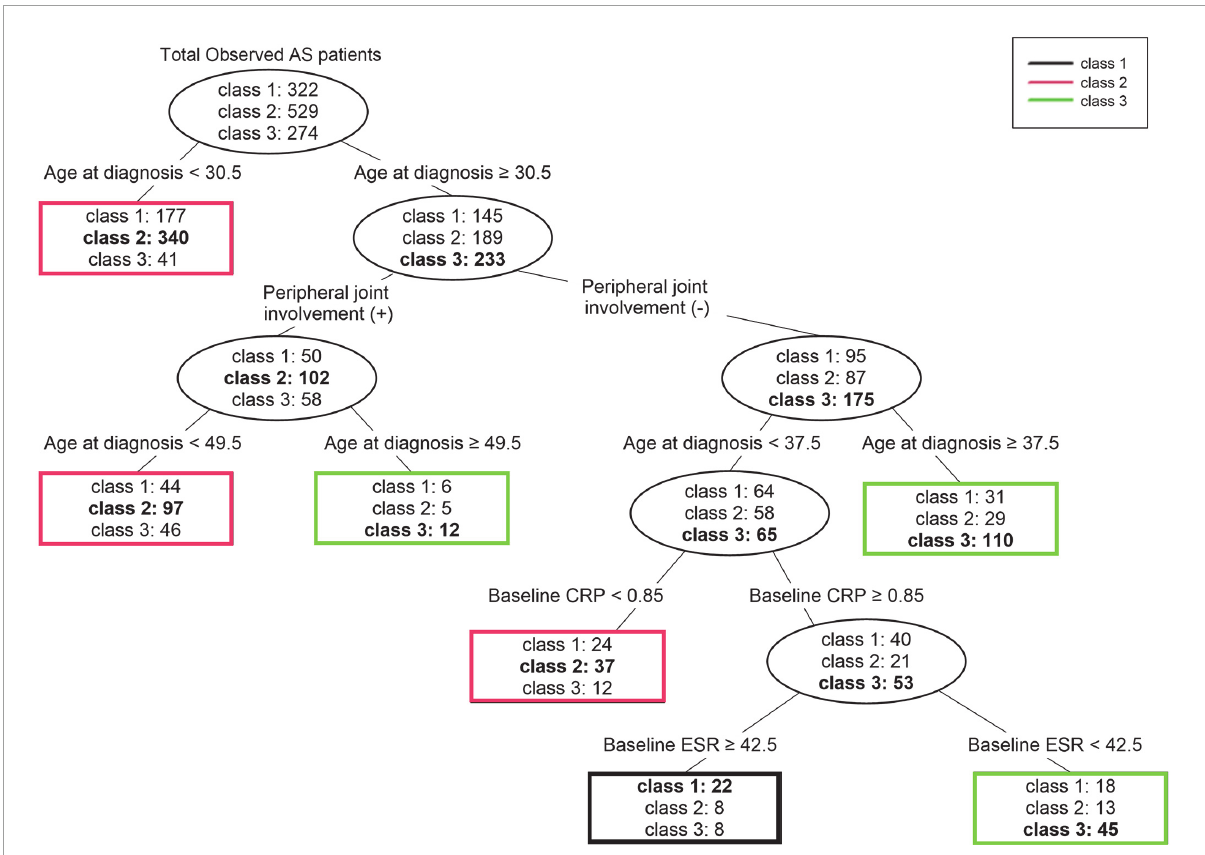
FIGURE4 Decision tree for prediction of three trajectory classes according to statistically significant clinical factors. For each terminal node, the class written in bold is the class that represents that node. AS, ankylosing spondylitis; CRP, C-reactive protein; ESR, erythrocyte sedimentation rate.